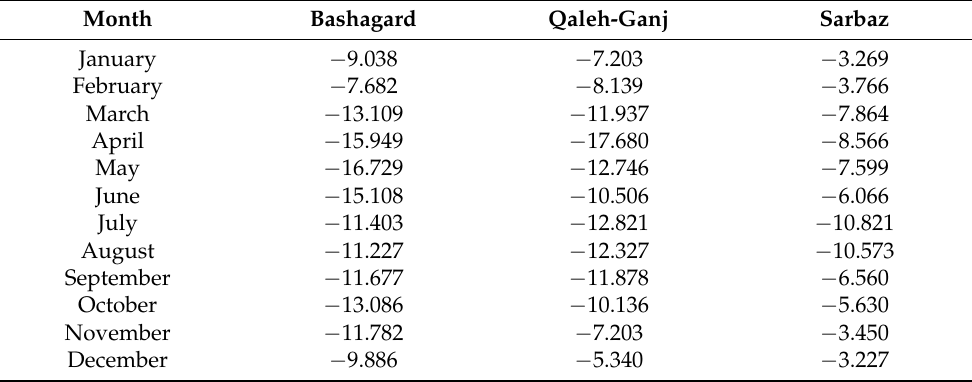
Table 3. Adaptive thresholds to improve LST values for Qaleh-Ganj, Sarbaz and Bashagard coun- ties,